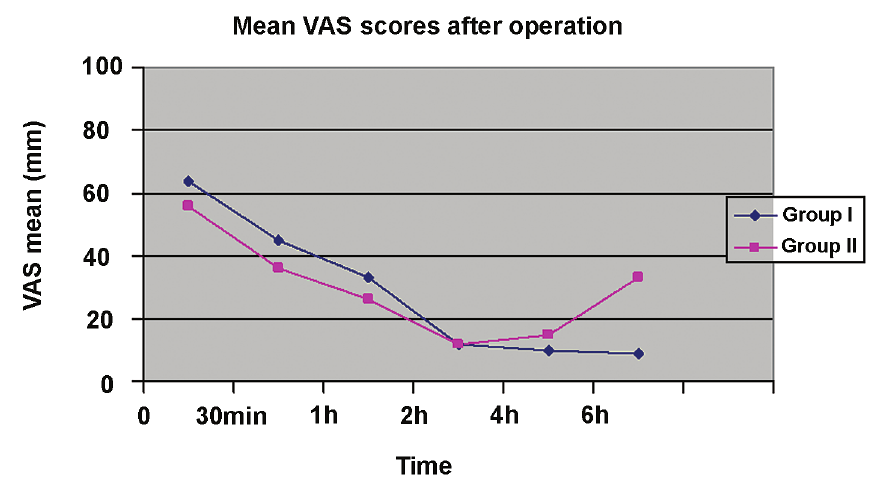
Figure 1 – The changes in postoperative visual analogue scale pain